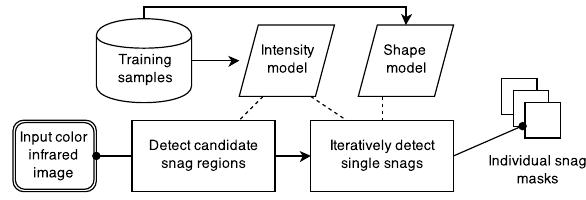
Figure 1. Overview of snag detection